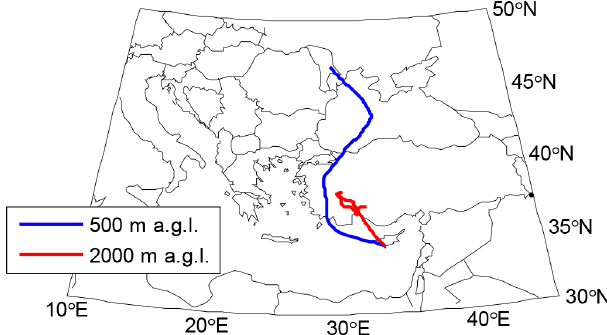
Figure 14. Averaged profiles at Vehmasmäki on 15 May 2016 at 19:00–21:00UTC. All profiles have been smoothed by a 300m run- ning mean. (a) Backscatter by PollyXT (wavelengths 355–1064nm) and attenuated backscatter by Halo (1565nm). (b) Particle linear depolarization ratio. Error bars represent measurement uncertainty. (c) Lidar